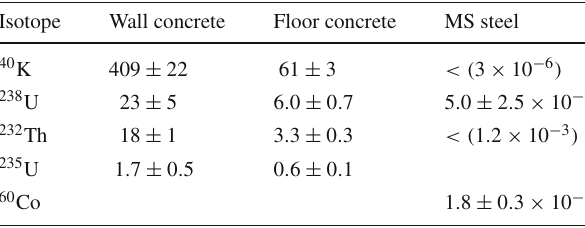
Table1 Specificactivities(inunitsofBq/kg)determinedfromradioas- say measurements for materials in the KATRIN spectrometer hall. The activity of the wall concrete was only measured for the basement walls; for the upper walls, the same distribution of activities was assumed. The steel activities were measured at the Oroville Low Background